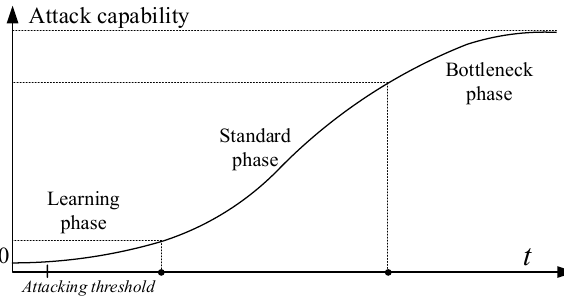
Figure 2. Typical time relationship of attacking capacity.